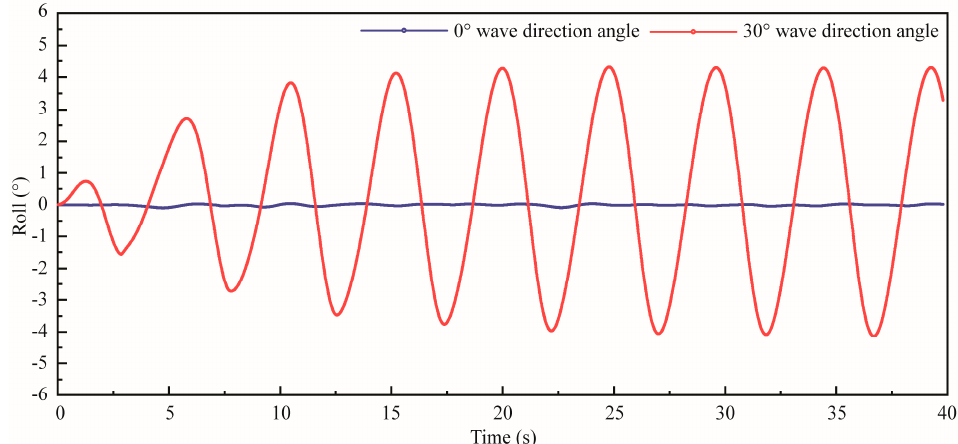
Figure 18. The roll motion with different wave direction angles at 5 level sea state.